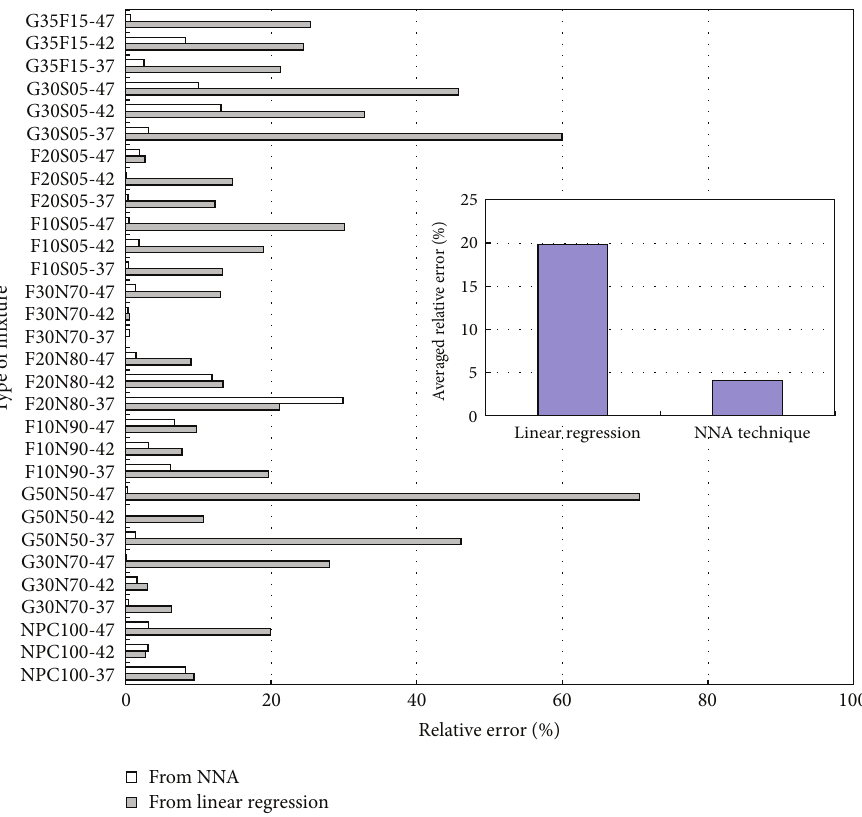
Figure 8: Comparison of relative errors from NNA and linear regression analysis with averaged relative errors.